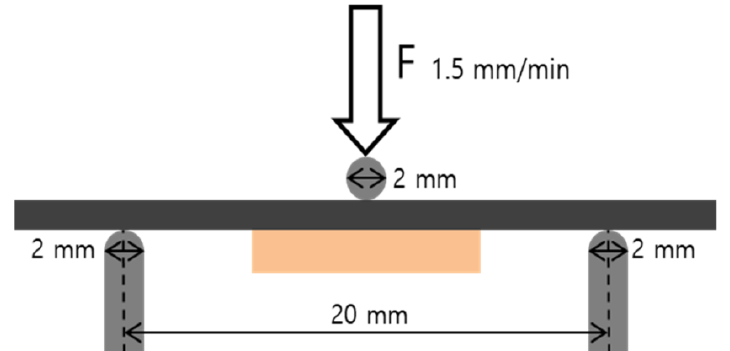
Figure 4. Schematic diagram illustrating the three-point bending test used to measure mechanical properties. The distance between the supports was 20 mm and the diameters of the bending piston and supports were each 2 mm. The bending piston was placed at the center and the crosshead speed of the loading part was 1.5 mm /